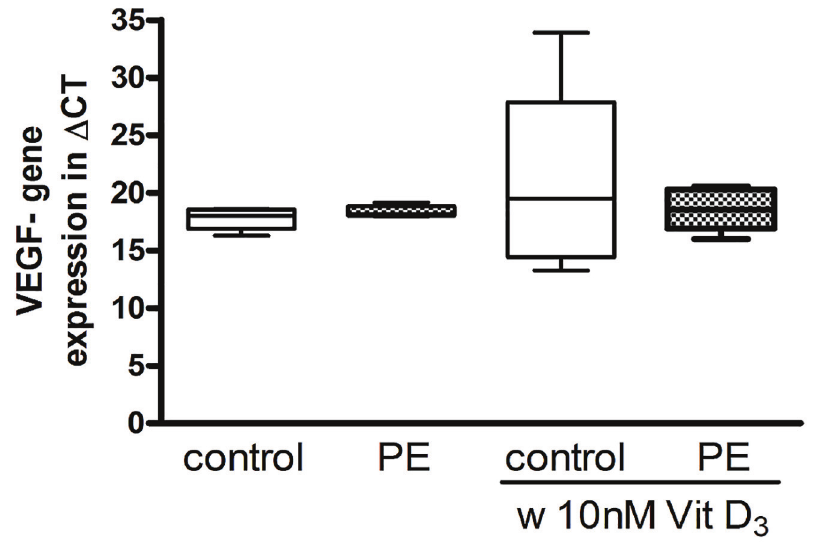
Fig 5. VEGF gene expression of HUVEC from uncomplicated (control) and preeclamptic (PE) pregnancies in the presence and absence of 1,25(OH) 2 vitamin D 3 (10 nM) in ug/ml. For each treatment medium triplets were created and three RT-PCR runs were performed for each patient. The ends of the whiskersrepresent the maximum and minimummeasured values. Distributionwas examinedusing Kolmogorov- Smirnov test. Continuous data were comparedwith Mann-Whitney